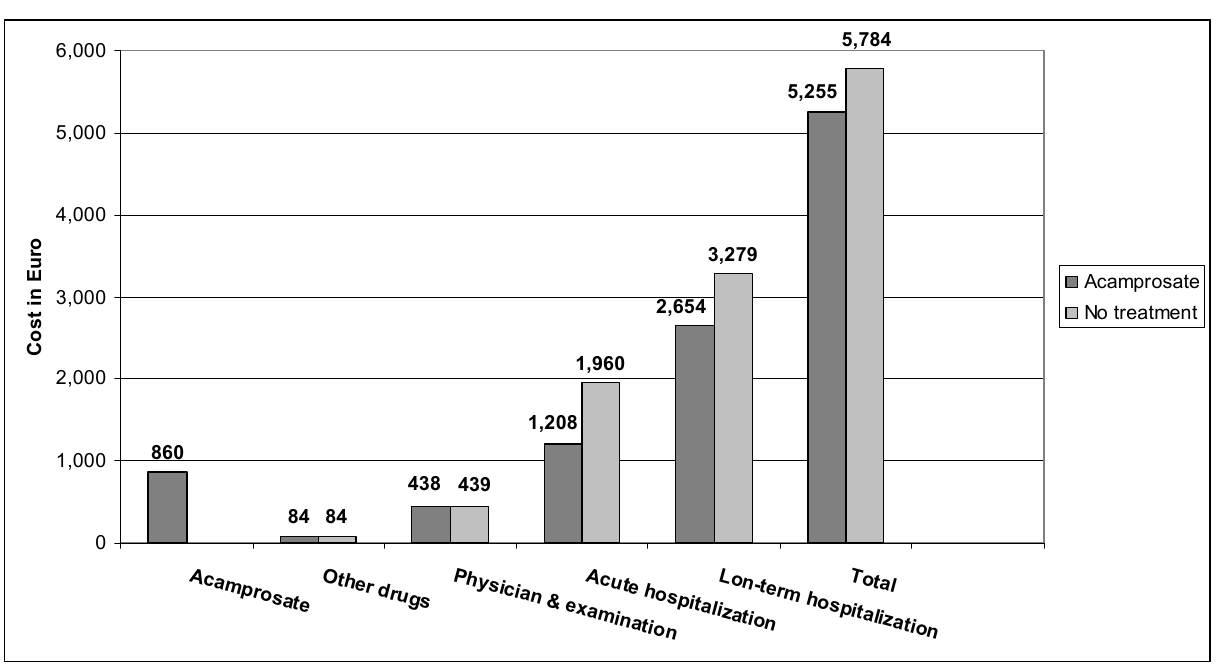
Figure 2. Distribution of costs (in Euros) for acamprosate versus no treatment in the Belgian study